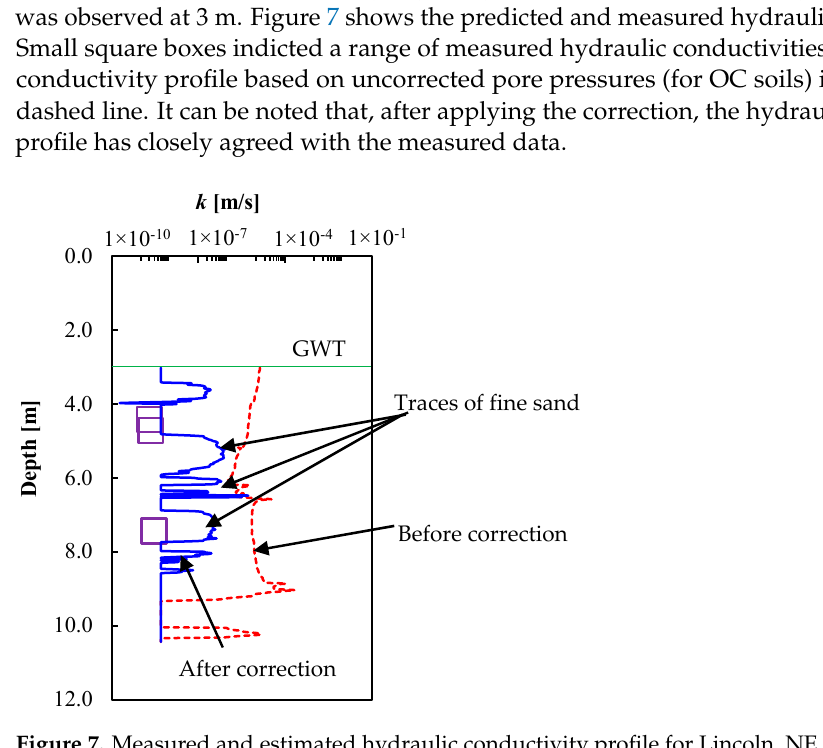
Figure 8. Measured and estimated hydraulic conductivity profile for Cowden, UK site. 5.3. Cheongna, Incheon, South Korea